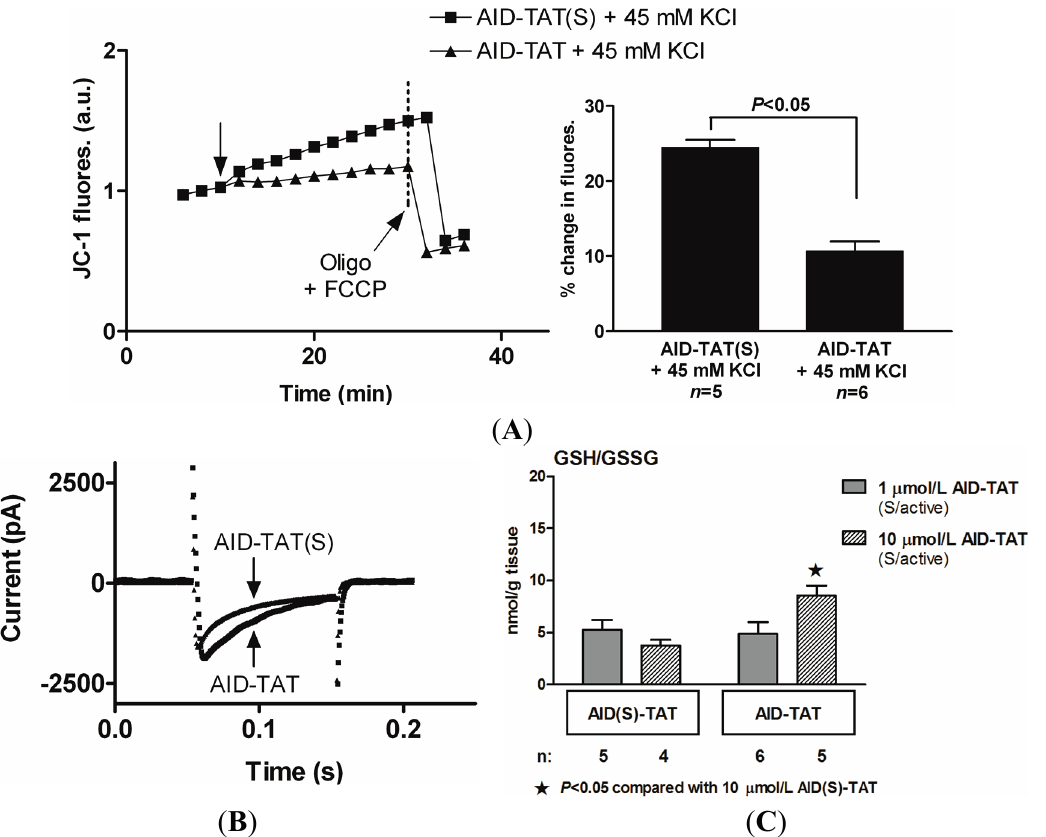
Figure 4. Targeted peptide delivery disrupts cross-talk between the L-type Ca 2+ channel and the mitochondria and reduces ischemia-reperfusion injury. ( A ) Exposure to